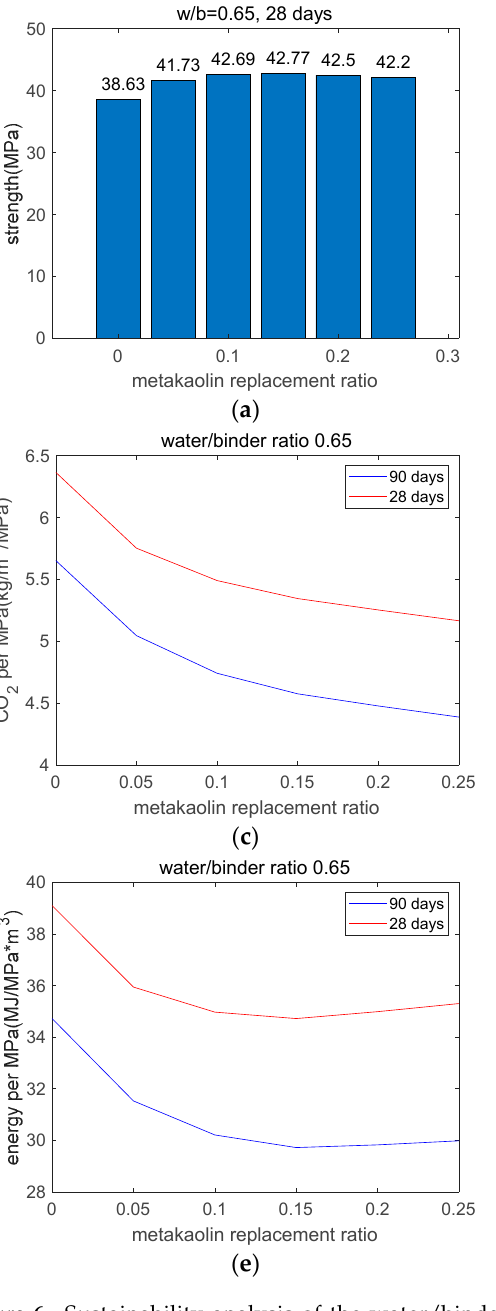
Figure 6. Sustainability analysis of the water/binder ratio 0.65 group. ( a ) strength on day 28 of water/binder ratio 0.65 group. ( b ) strength on day 90 of water/binder ratio 0.65 group. ( c ) normalized CO 2 emissions of water/binder ratio 0.65 group. ( d ) normalized resource consumption of water/binder ratio 0.65 group. ( e ) normalized energy consumption of water/binder ratio 0.65 group. ( f ) effect of superplasticizer on normalized energy